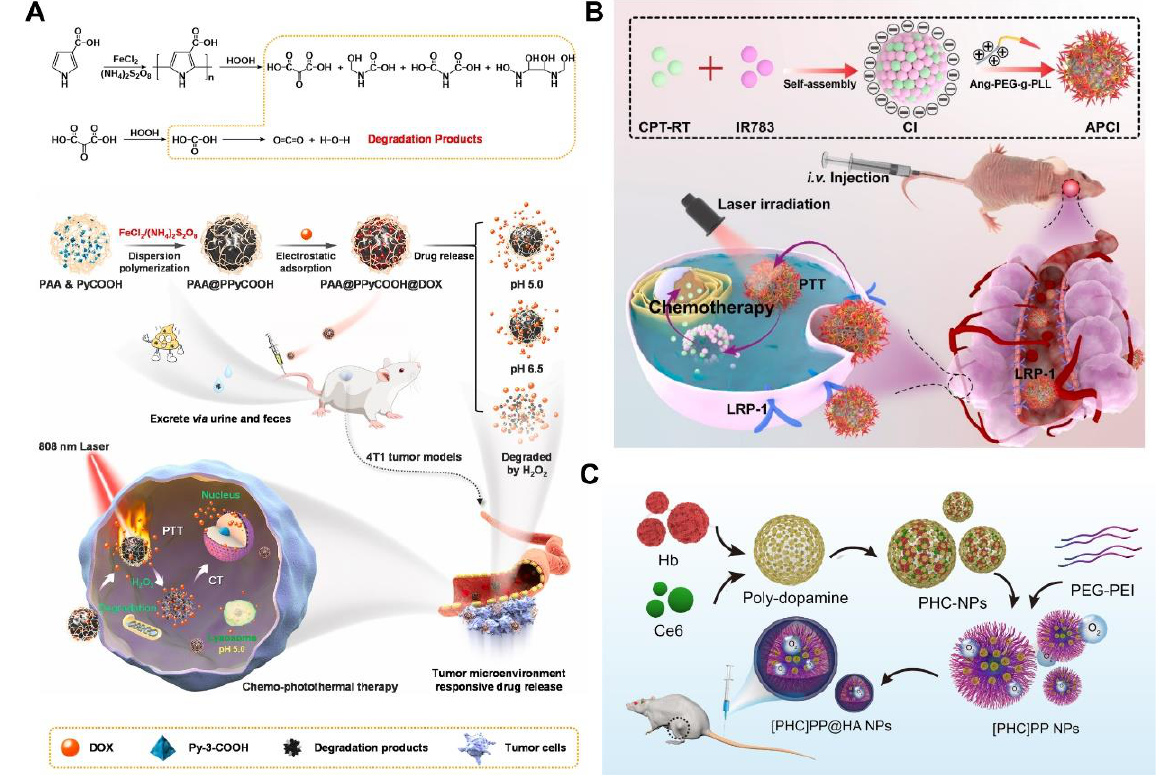
Figure 4. Preparation of high drug-loading nanomedicines from organic nanomaterials for com- bined chemotherapy-photothermal treatment of tumors. ( A ) Schematic illustration of the prepara- tion of PAA@PPyCOOH@DOX based on degradable conductive polymer PPyCOOH for chemo– photothermal therapy [44]. ( B ) Schematic illustration of preparation of Ang-PEG-g-PLL@CPT- RT@IR783 (APCI) [40]. ( C ) Schematic illustration of the design and prepared lollipop-like nanoparti- cles assembled with gossypol, doxorubicin, and polydopamine via π - π stacking [78]. Reprinted with permission from Refs. [40,44]. Copyright 2021, Elsevier. Reprinted with permission from Ref. [78]. Copyright 2018, John Wiley & Sons, Inc.